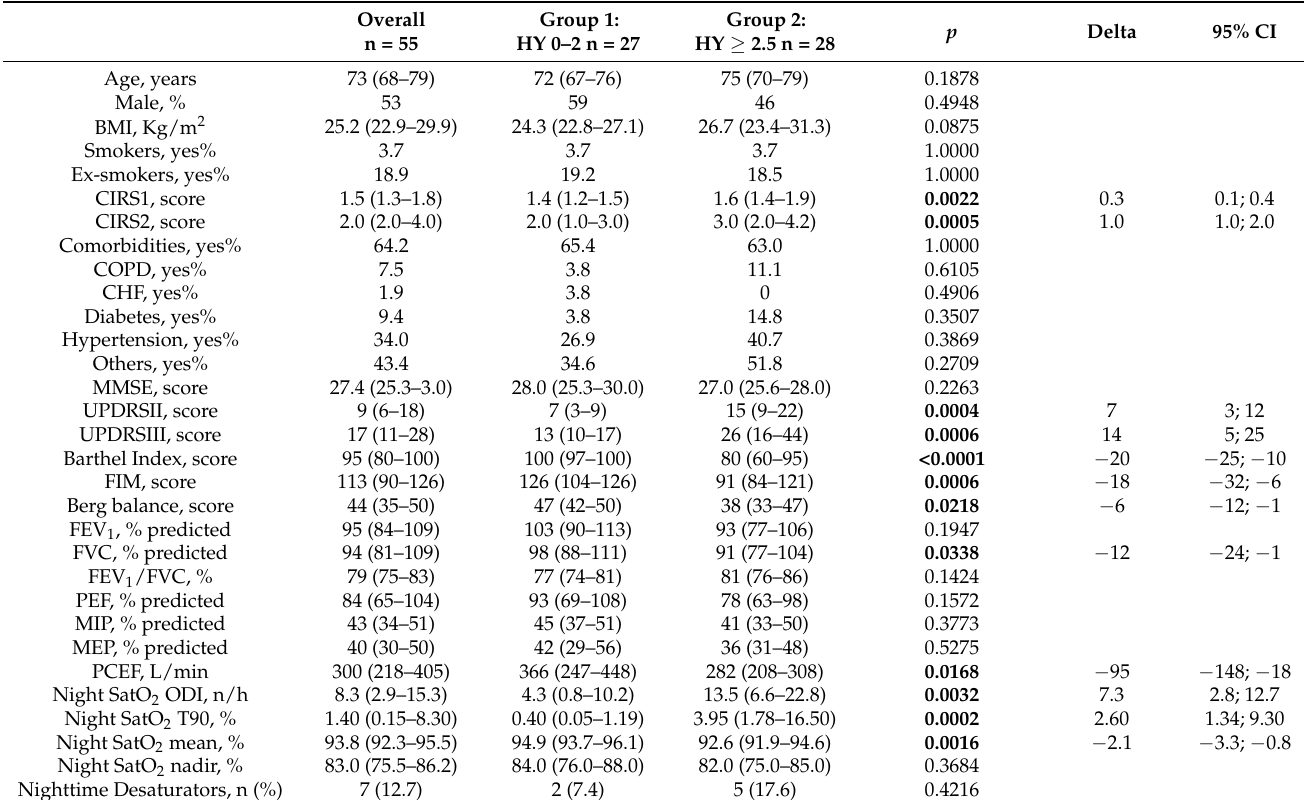
Table 1. Characteristics of PD patients at admission: results for the overall sample and mild vs. moderate–severe subgroups. Overall Group 1: n = 55 HY 0–2 n =